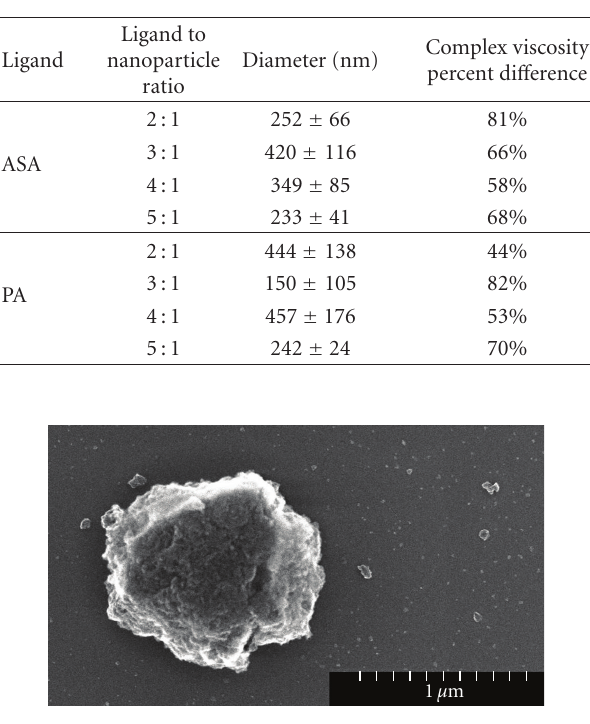
Table 3: Agglomerate diameters and complex viscosity percent di ff erence of ligand capped nanocrystals in PMMA.